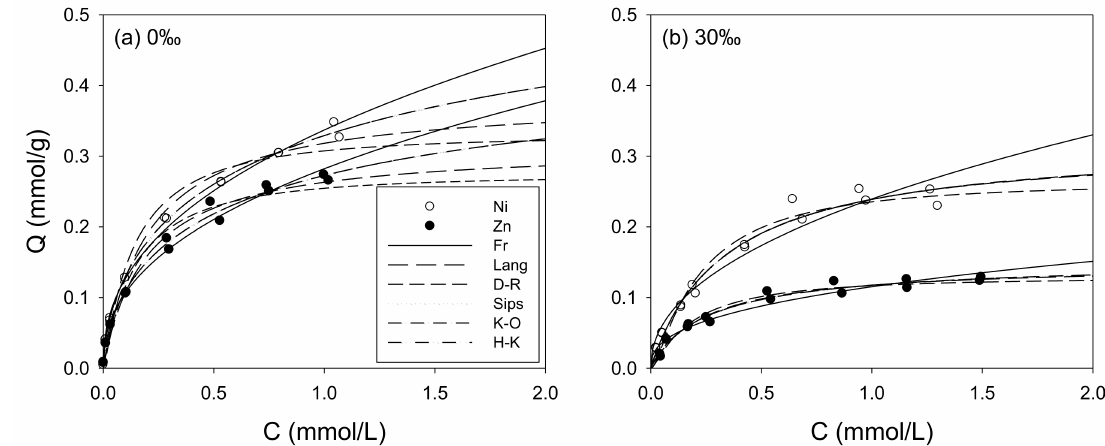
Figure 3. Single adsorption of Ni and Zn onto PINM at di ff erent salinities (pH = 5.0). ( a ) 0% (cid:24) and ( b ) 30% (cid:24) . Lines represent adsorption